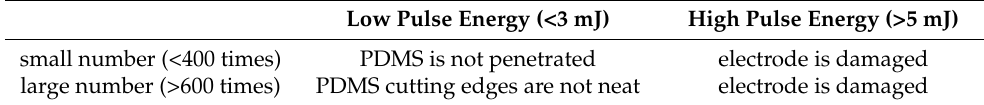
Table 1. Combinations of parameters too high or too low lead to unsatisfactory experimental results. Low Pulse Energy (<3 mJ) High Pulse Energy (>5 mJ) small number (<400 times) PDMS is not penetrated electrode is damaged large number (>600 times) PDMS cutting edges are not neat electrode is